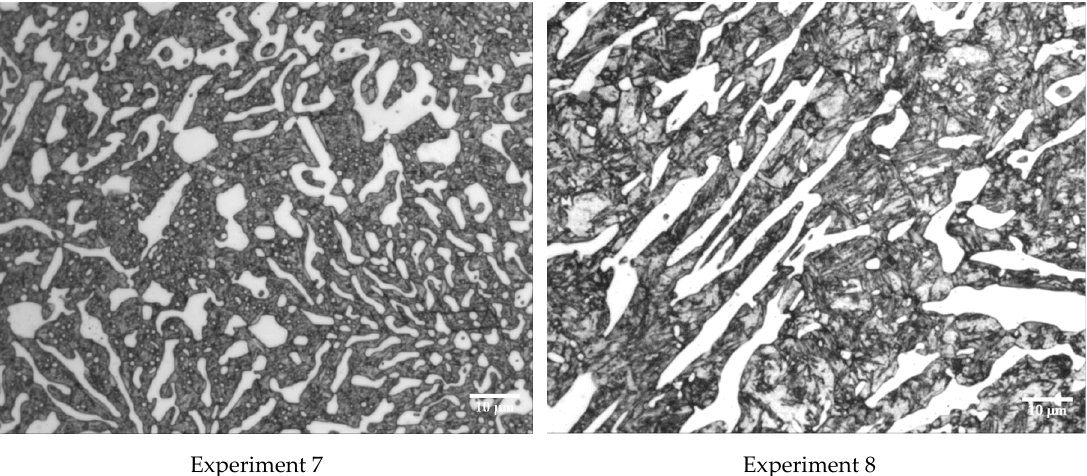
Figure 8. Representative micrographs of each of the eight experiments. All were obtained at 600× magnification.